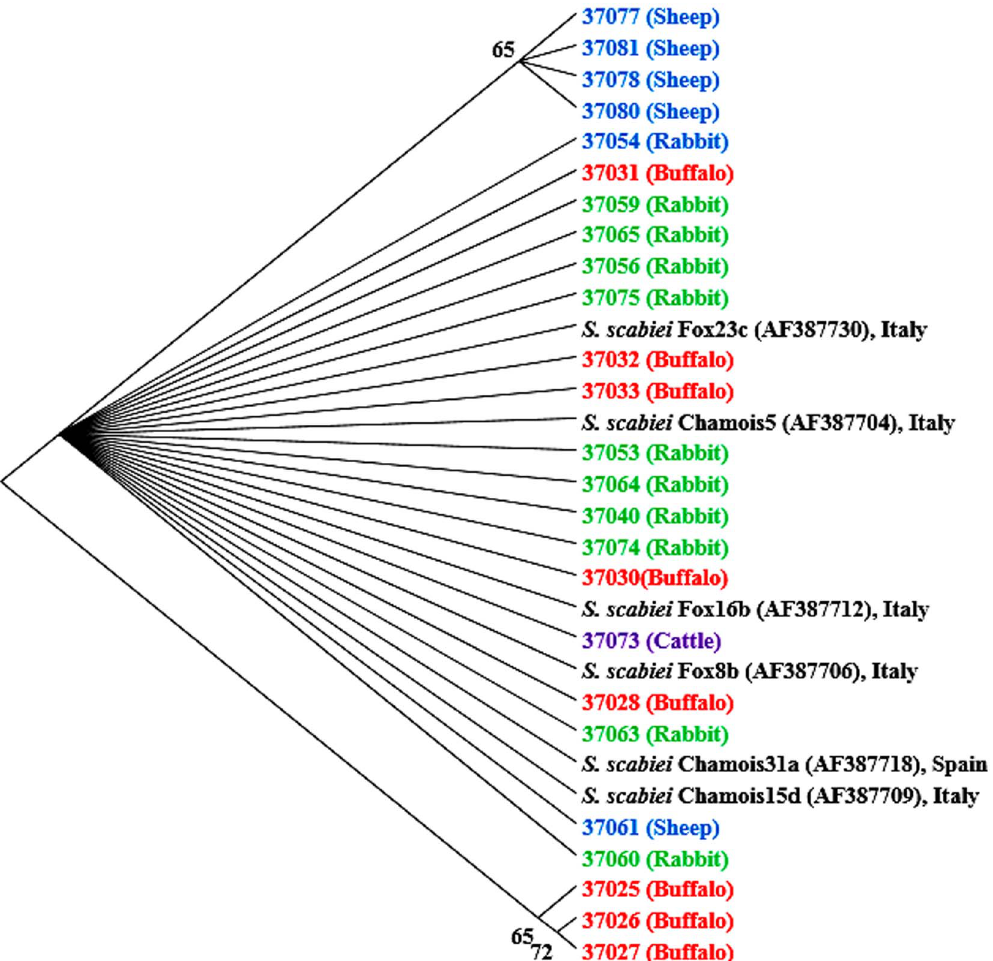
Figure 1. Un-rooted NJ tree showing genetic relationship of Egyptian Sarcoptes mites to others in the GenBank database based on ITS2 sequences. Evolutionary relationships of 31 taxa were inferred using the neighbor-joining method [46]. Numbers at the internodes correspond to percent bootstrap values from 2,000 replicates. Branches corresponding to partitions produced in less than 50% bootstrap replicates are collapsed. Sequences in bolded colors and with no GenBank accession numbers are generated from Egyptian specimens.